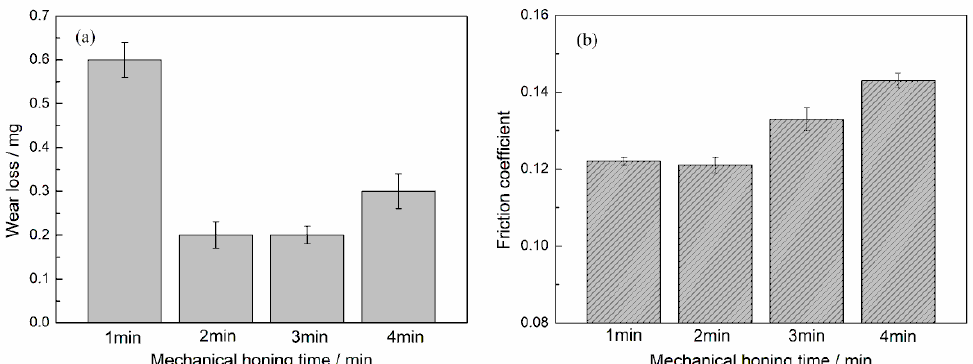
Figure 12. Effect of mechanical honing time on the ( a ) wear loss and ( b ) friction coefficient.